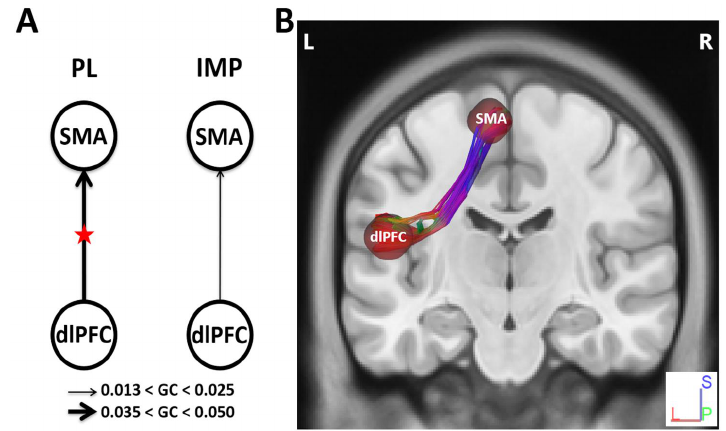
Figure 5. Schematic representation of functional and structural connectivity between the dorsolateral prefrontal cortex (dlPFC) and supplementary motor area (SMA). The functional network activity results are adapted from our previous fMRI study [4] of the same advanced jazz improvisers. ( A ) Granger causality from dlPFC to SMA during pre-learned and improvisation conditions. The red stars (left panel) represent an increase in network interaction directions ( p < 0.05) when the causal strength during overall pre-learned is compared with overall improvisation. ( B ) Underlying white matter fiber pathway connecting dlPFC and SMA.